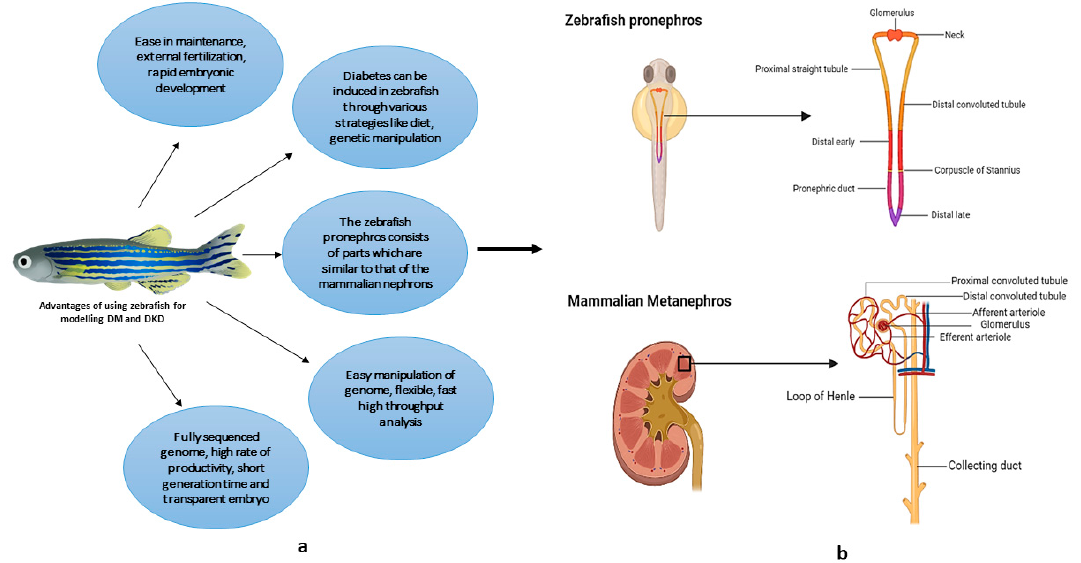
Figure 1. ( a ) Representation of the advantages of the zebrafish as a DM and DKD model; ( b ) similar segmentation pattern shared by Zebrafish pronephric and Human Metanephric nephrons (Created using Biorender.com, accessed on 20 February 2022).